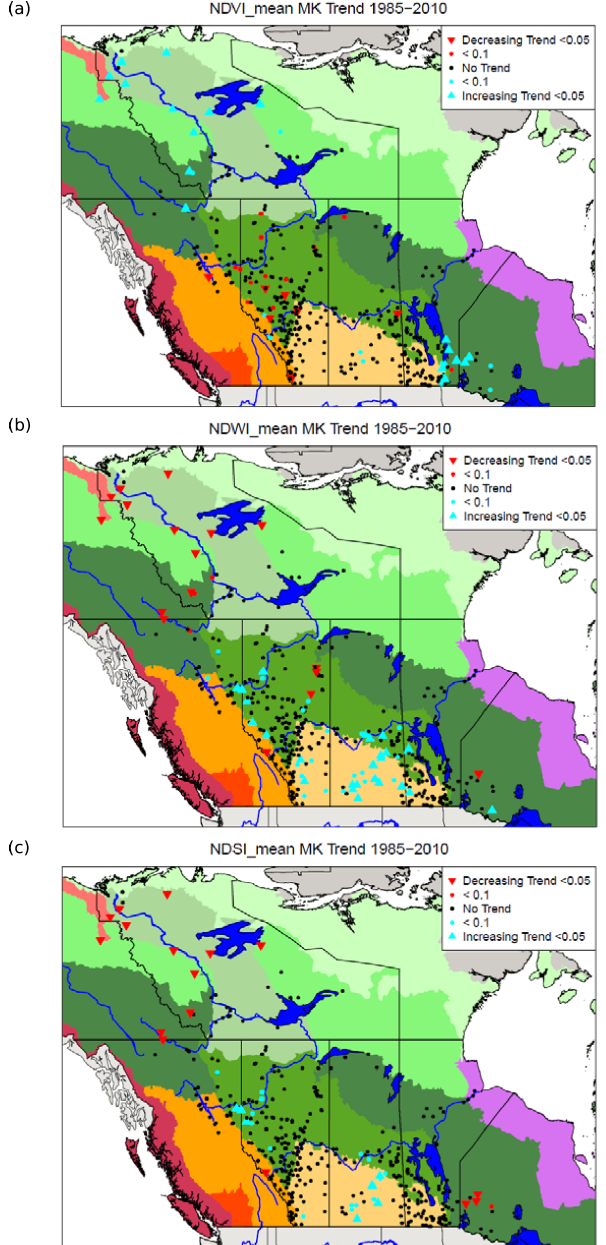
Figure 13. Trends in mean (a) NDVI, (b) NDWI, and (c) NDSI between 1985 and 2010. The ecozone legend is as in Fig.